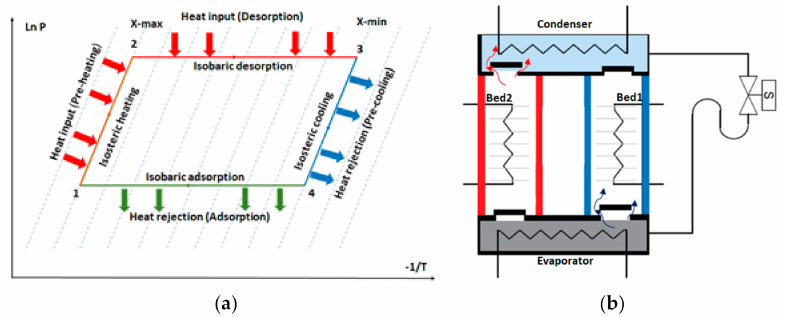
Figure 2. ( a ) Clapeyron diagram of the simple adsorption–cooling cycle. ( b ) Schematic diagram of the adsorption–cooling